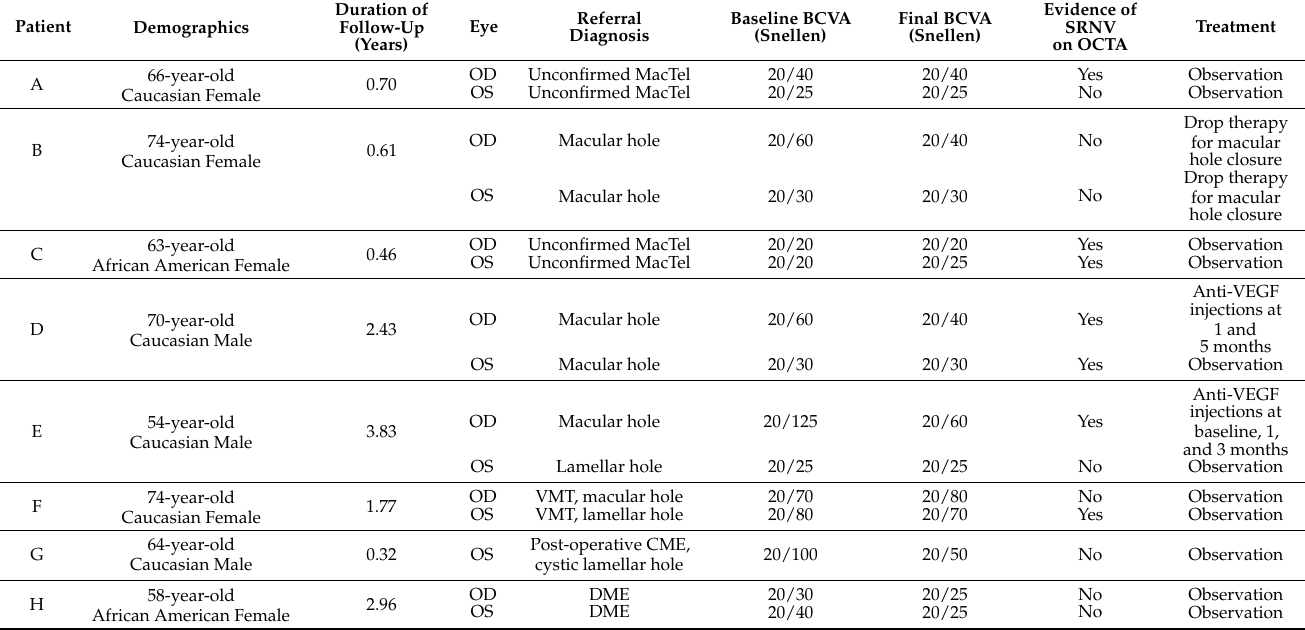
Table 1. Demographic and Clinical